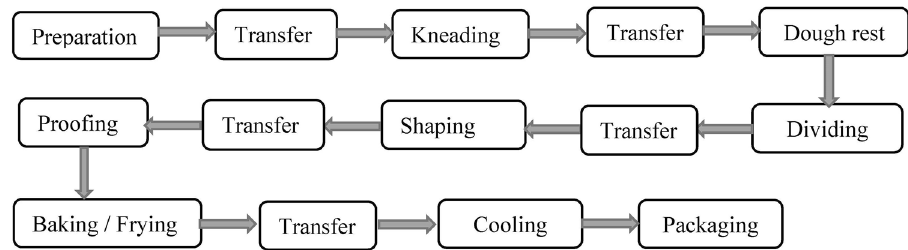
Figure 1. A simplified processing route for bakery products.